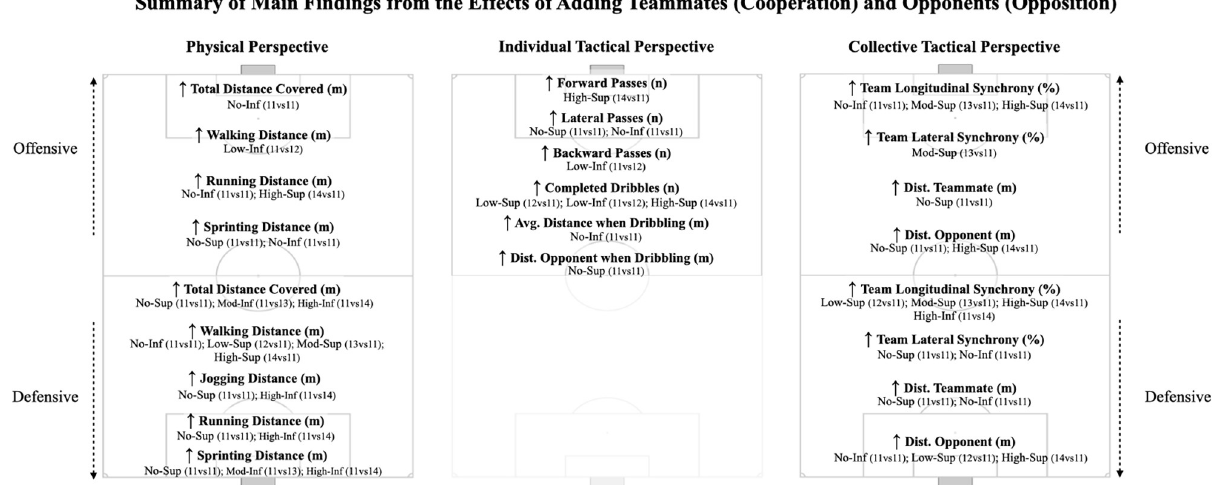
Fig 6. Summary of main findings from adding teammates (cooperation perspective) or opponents (opposition perspective) during game-based scenarios on the physical, individual and collective tactical behaviours. Dist = distance; Avg = average; n = number; m = meters.